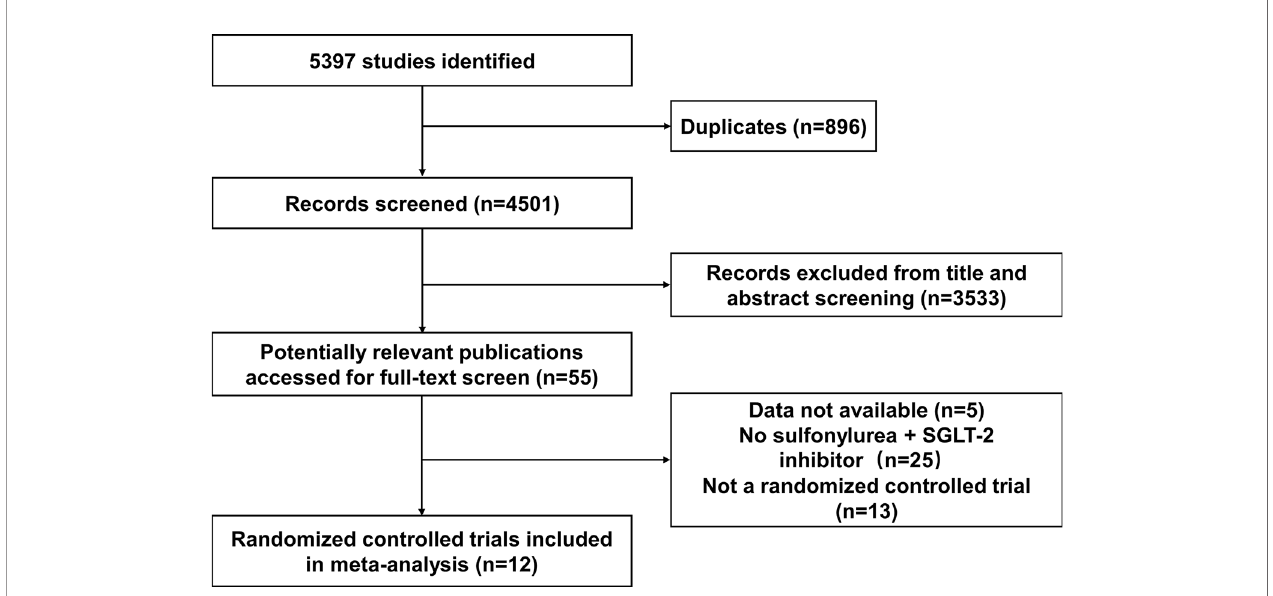
FIGURE 1 | Flow diagram of study identi fi cation, selection, and